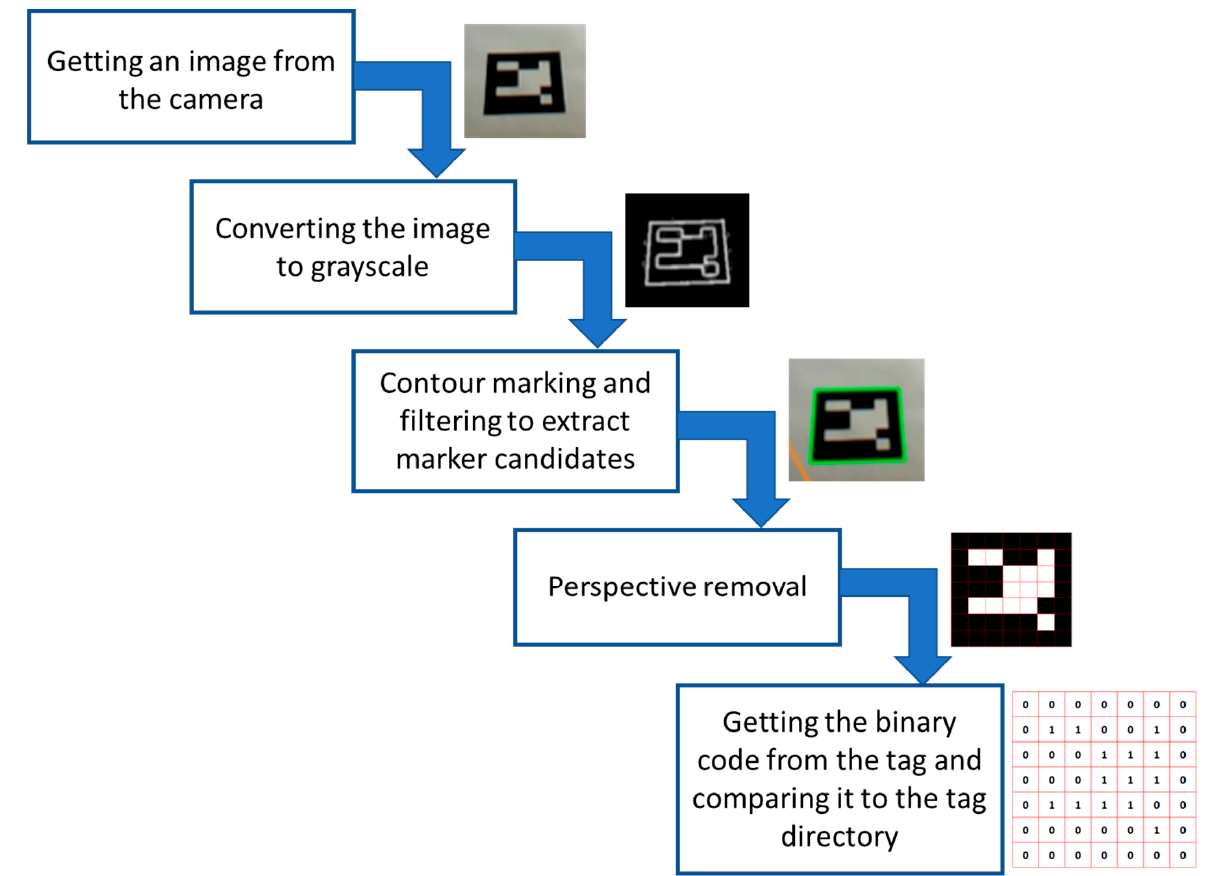
Figure 5. Marker detection process .